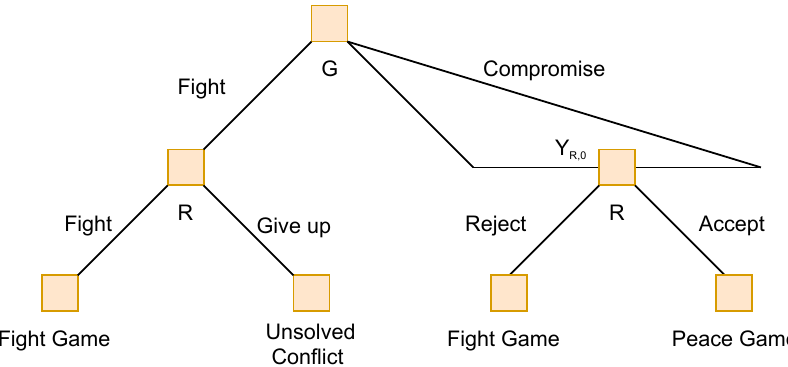
Figure 1. Destabilisation Warfare game [66], where the government and rebel decision points are